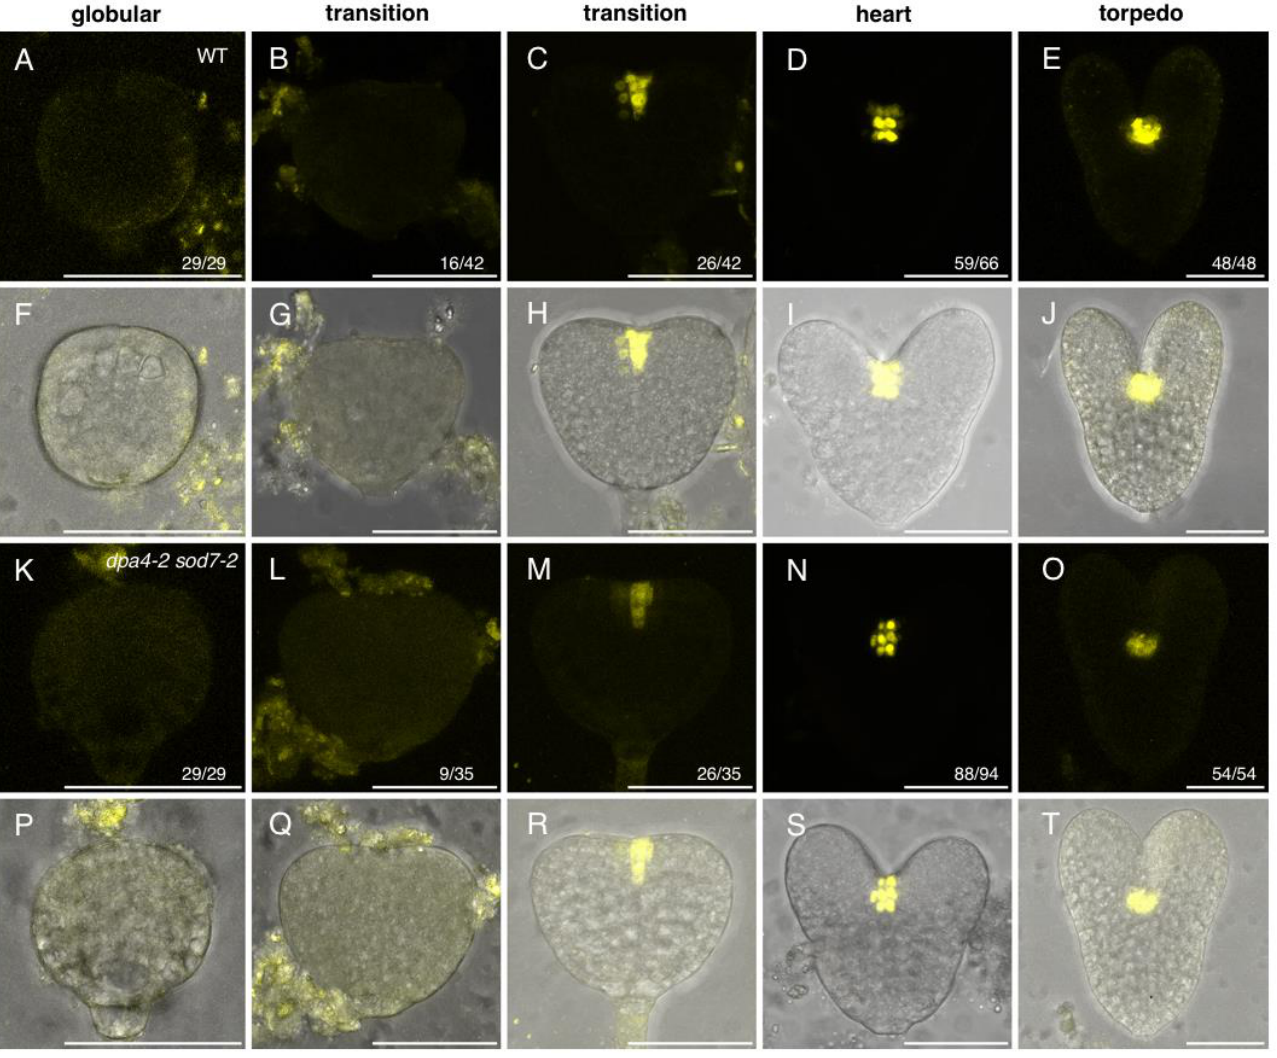
Figure 1. pCLV3:mCHERRY-NLS expression in developing wild-type and dpa4-2 sod7-2 embryos. Panels ( A – J ) show wild-type embryos, while panels ( K – T ) show dpa4-2 sod7-2 embryos. For each genotype, the upper row shows pCLV3:mCHERRY-NLS signal (in yellow), while the lower row shows an overlay of the pCLV3:mCHERRY-NLS signal (in yellow) and the transmission picture (in grey). Images are maximum projection form stacks of confocal images. The number of similar observations out of the total number of observations is shown in the lower right corner as a fraction. The embryo stage is indicated above the panels. For the transition stage, embryos without or with pCLV3:mCHERRY-NLS expression are shown. Scale bars = 50 µm.